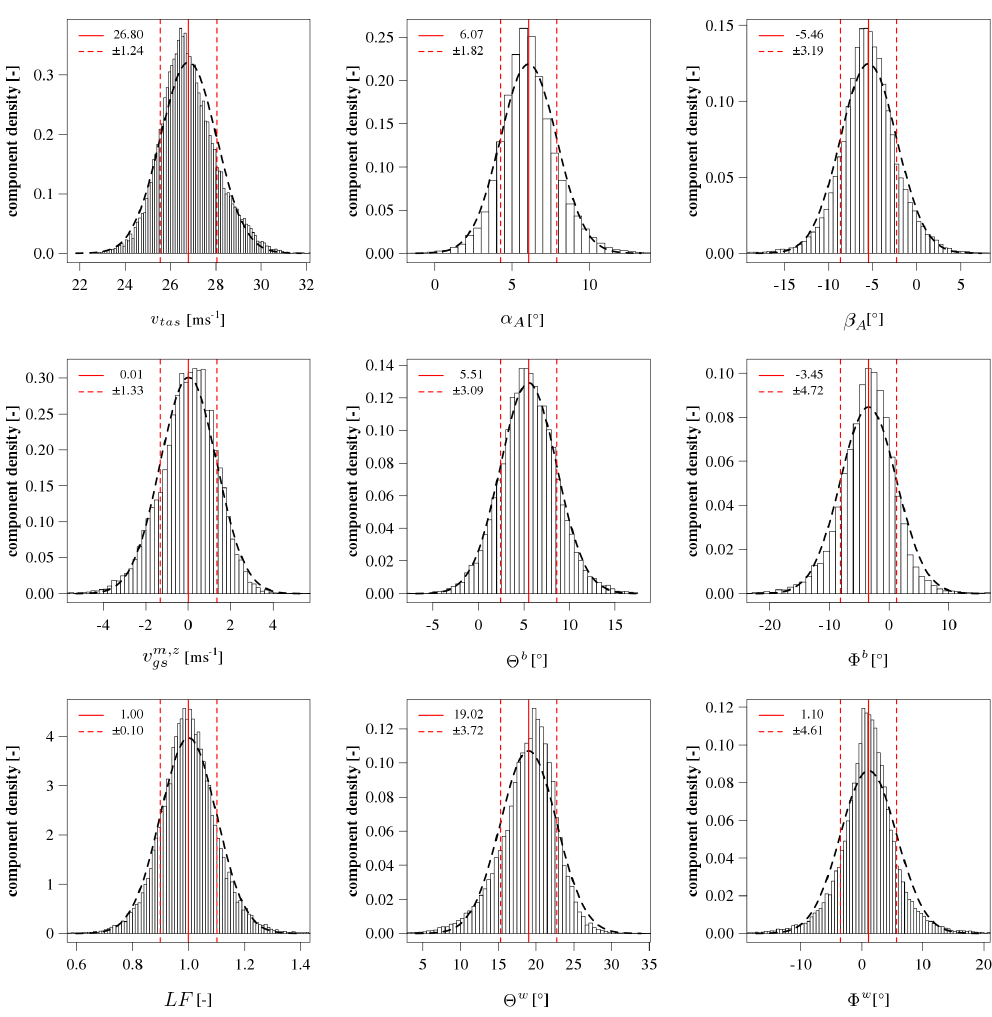
Fig. 4. Histograms of aircraft properties derived for the flight on 31 July 2009 (Table 3). Component density is scaled so that the histograms have a total area of one. Red vertical lines indicate distribution average (solid) and standard deviation (dashed). The black dashed bell curve displays a reference normal distribution: True airspeed ( v tas ), attack angle ( α A ), sideslip angle ( β A ), aircraft vertical velocity ( v m ,z gs ), trike pitch- ( 2 b ) and roll ( 8 b ) angles, loading factor (LF, the ratio of lift- to weight force), as well as wing pitch- ( 2 w ) and roll ( 8 w ) angles.